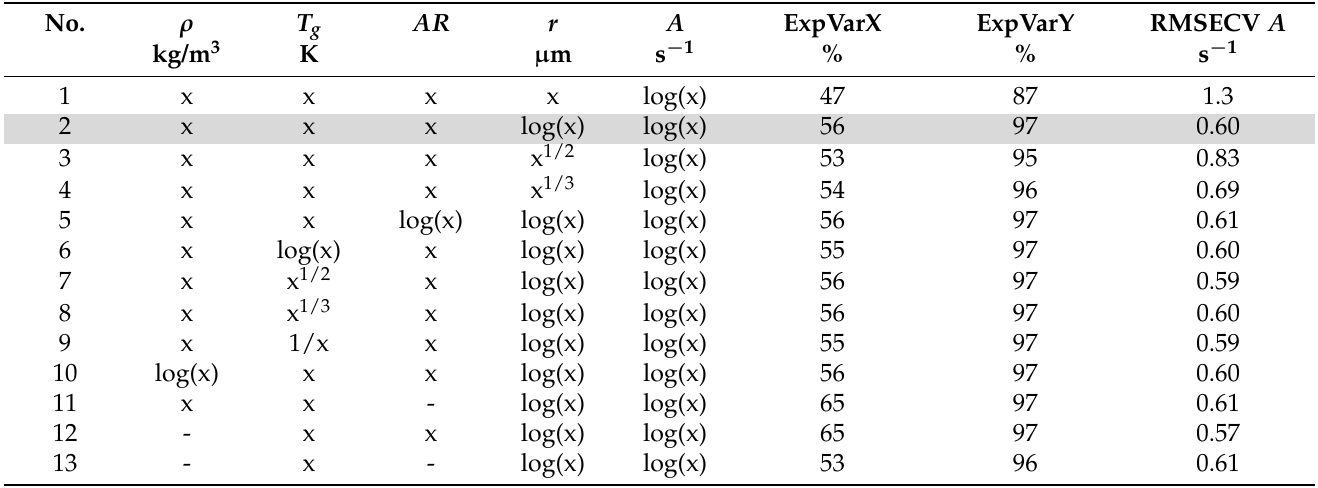
Table 3. Table of tested partial least squares regression (PLS) models for obtaining values of A . All models have two PLS components. ExpVar = explained variance, RMSECV = root means squared error of cross validation. x = parameter included, - = parameter not included.